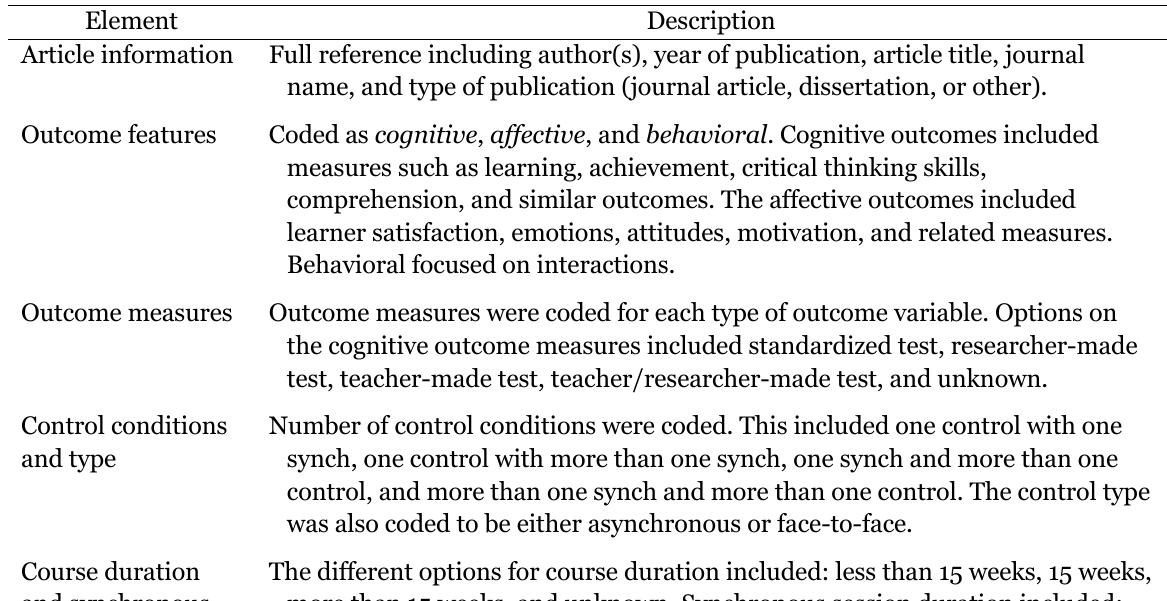
Table 2 Description of the Coded Elements for Each Research